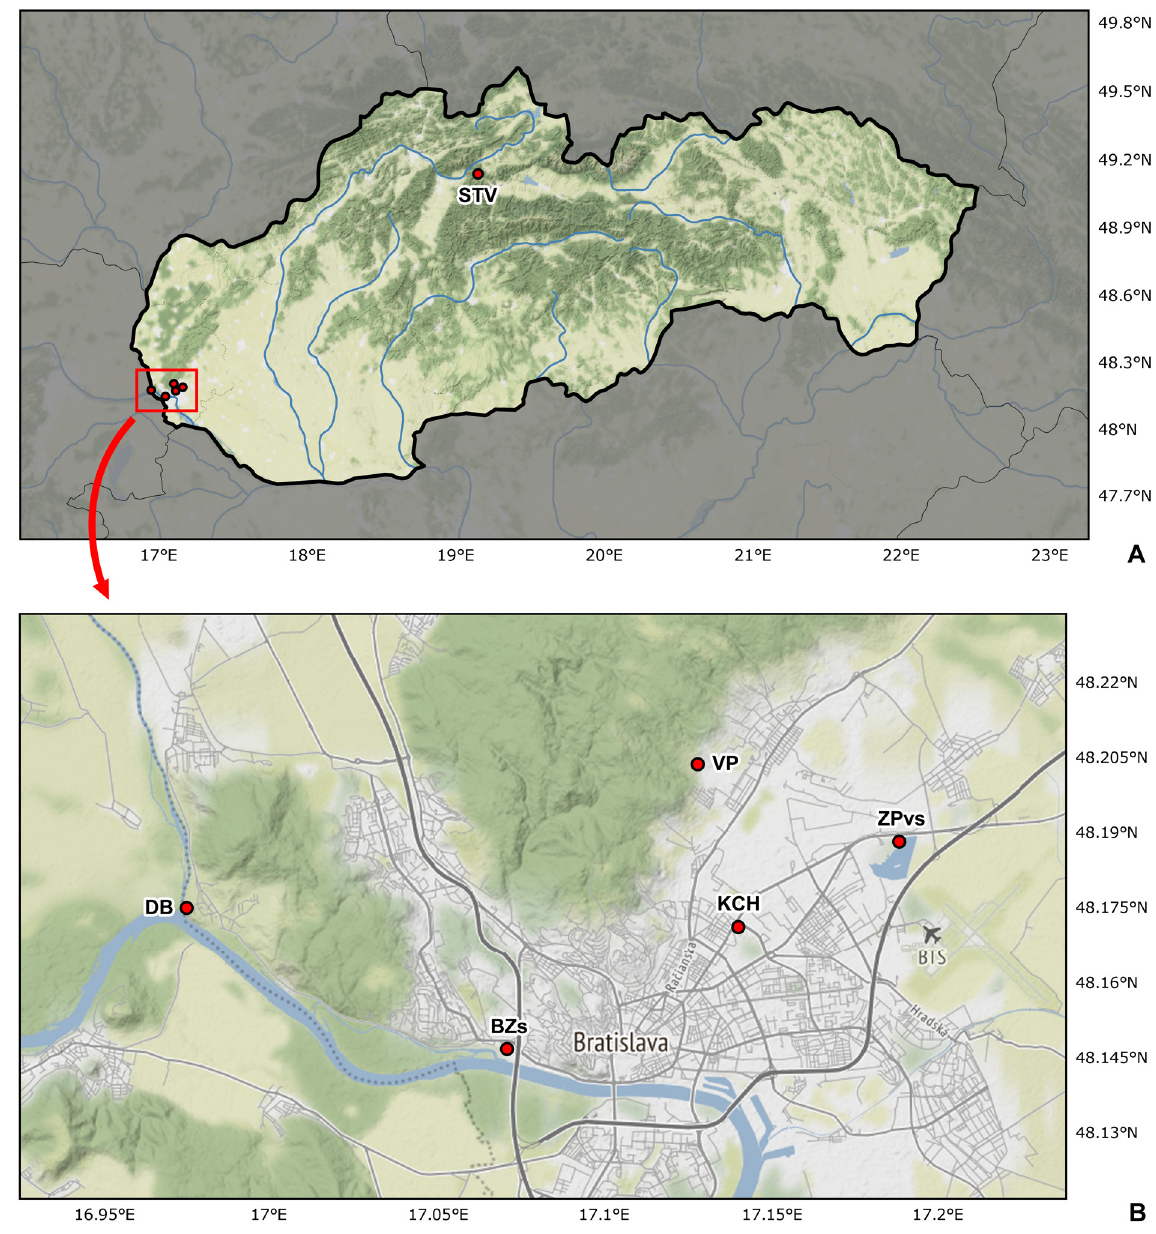
Fig. 2. Sampling sites of nine new gastrotrich species discovered in Slovakia. A . One locality (STV) was situated in northern Slovakia, while five localities were concentrated in the capital city of Bratislava (marked by the red rectangle). B . Detail of the Bratislava district showing the localization of five sampling sites. Map tiles by © Stamen Design, under a Creative Commons Attribution (CC BY 3.0) license. Data by OpenStreetMap, under